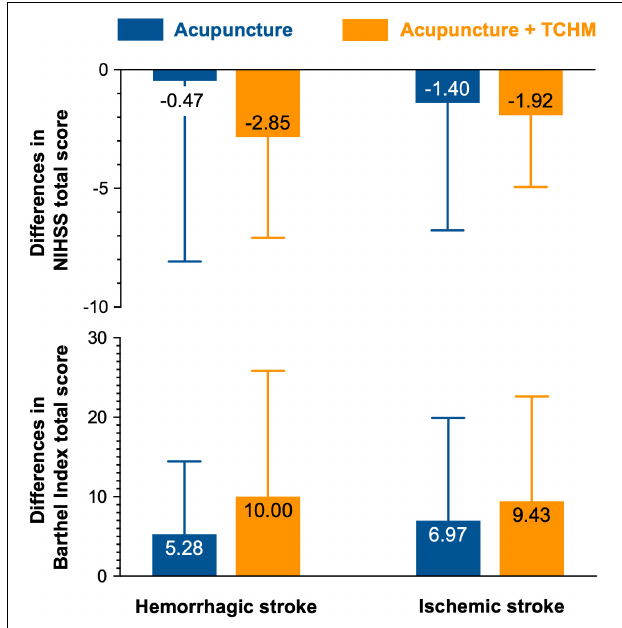
FIGURE 2 | Differences in NIHSS and BI total scores.